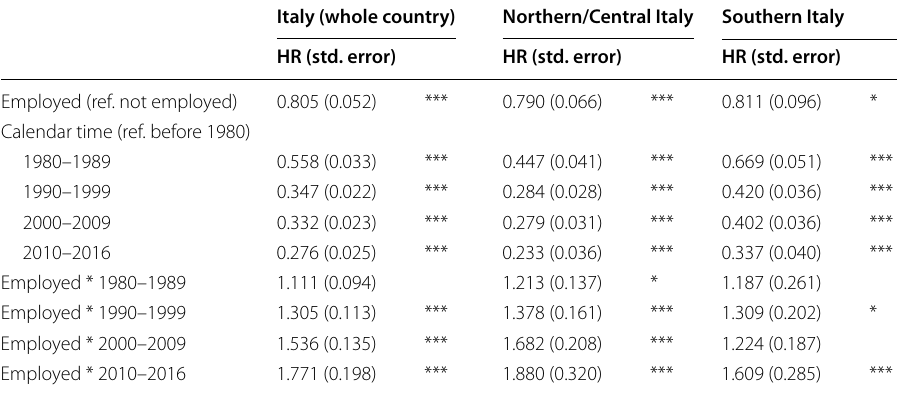
Table 7 Employment status and transition to motherhood over time, only native women. Cox models, HRs are reported with standard errors in